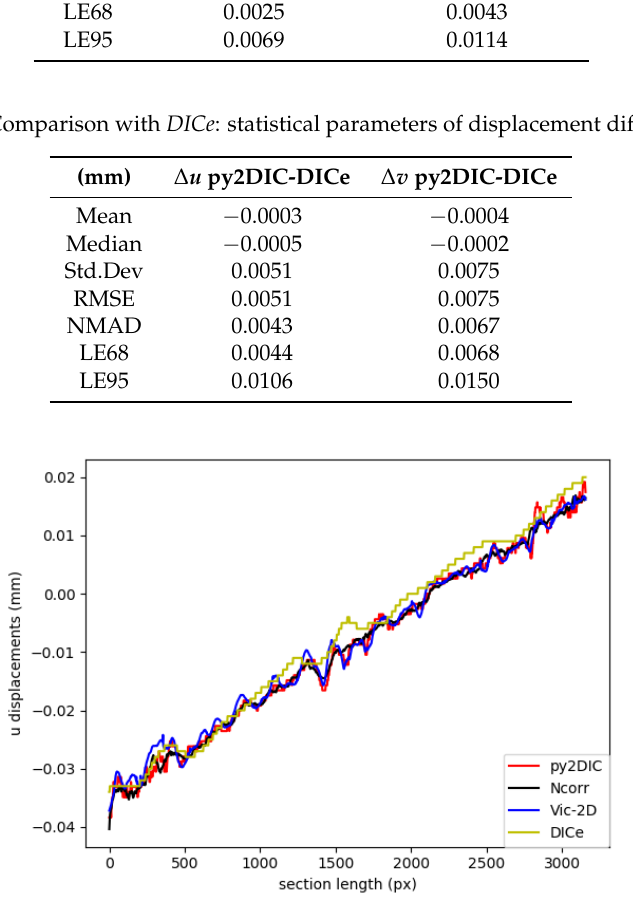
Figure 12. Comparison of u displacement along the section BB among py2DIC , Ncorr , Vic-2D and DICe .